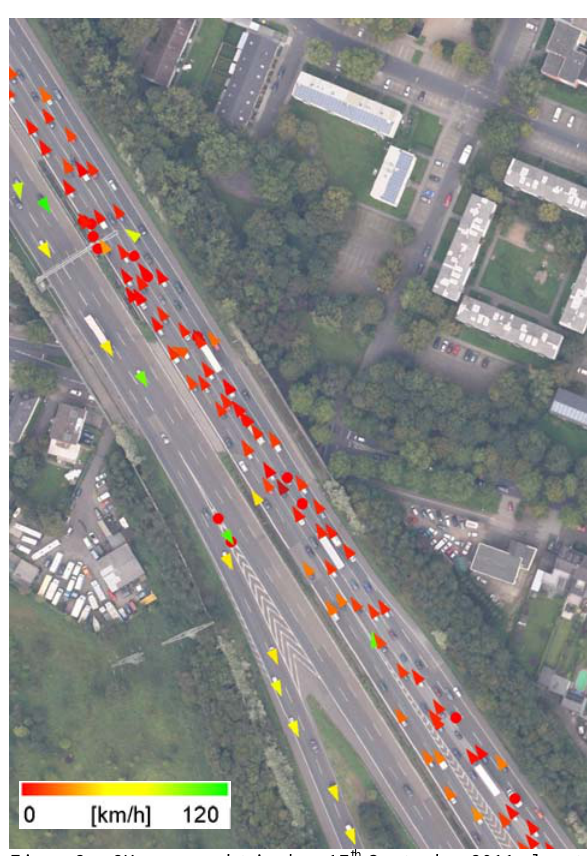
Figure 2. 3K+ scene obtained on 17 th September 2011 close to Cologne/Germany at a flight height of 1500 m AGL.